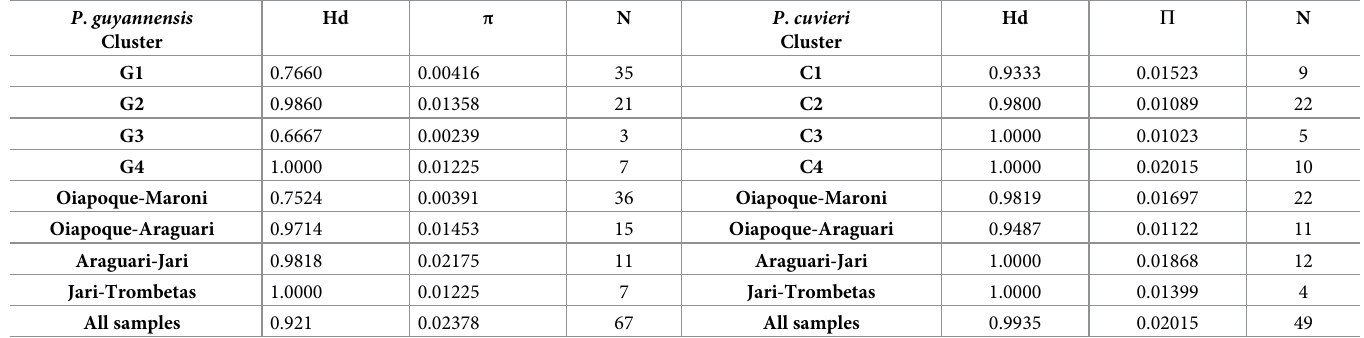
Table 1. Haplotype diversity (HD), nucleotide diversity ( π ) and the number of individuals (N) in the clusters identified by the BAPS for P . guyannensis (G1, G2, G3, G4) and P . cuvieri (C1, C2, C3, C4), the interfluves of the study region: Maroni-Oiapoque; Oiapoque-Araguari; Araguari-Jari e Jari-Trombetas and the complete dataset for each